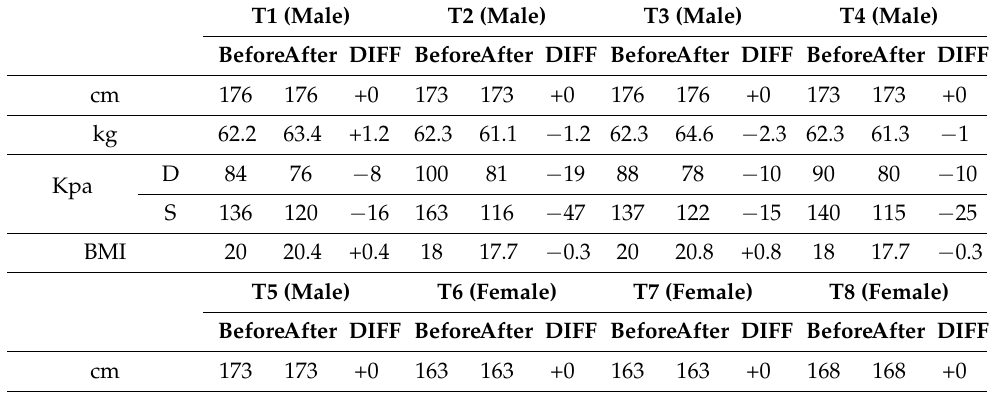
Table 5. Statistical comparison of body quality and physical fitness of subjects in the experimental group before and after the